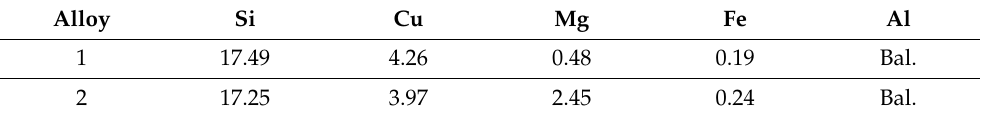
Table 1. Chemical compositions of the studied alloys (wt.%). Alloy